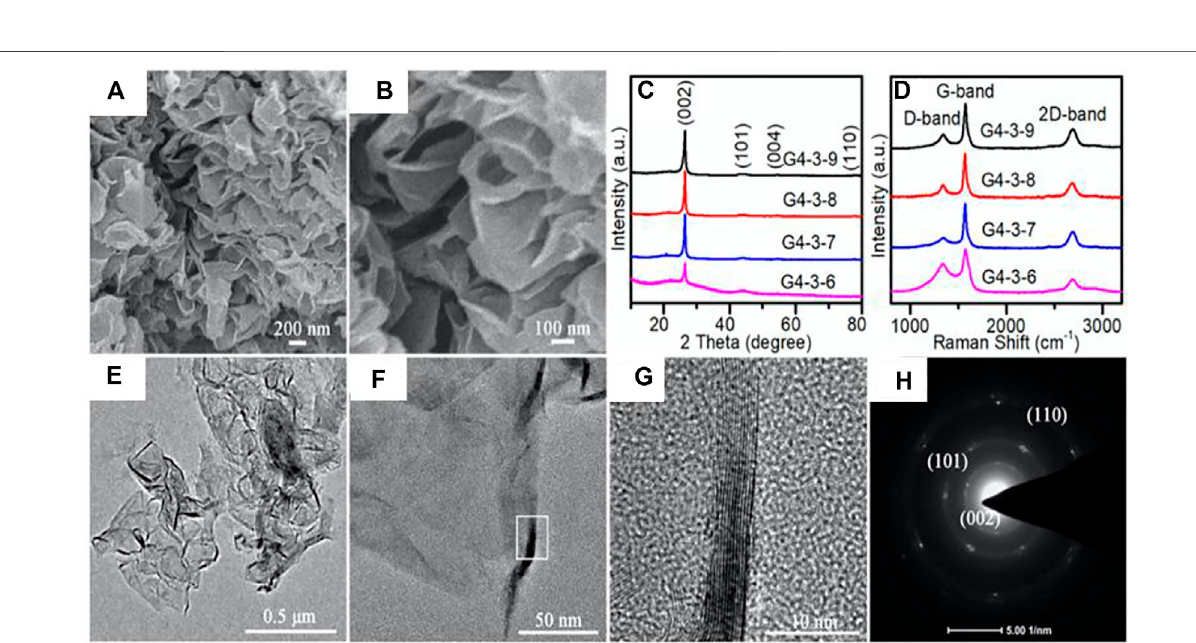
Frontiers in Nanotechnology |